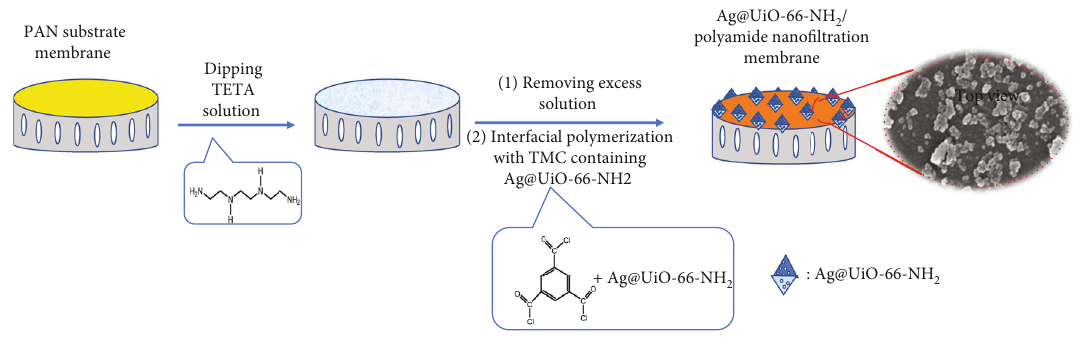
Figure 15: Fabrication of Ag@UiO-66-NH